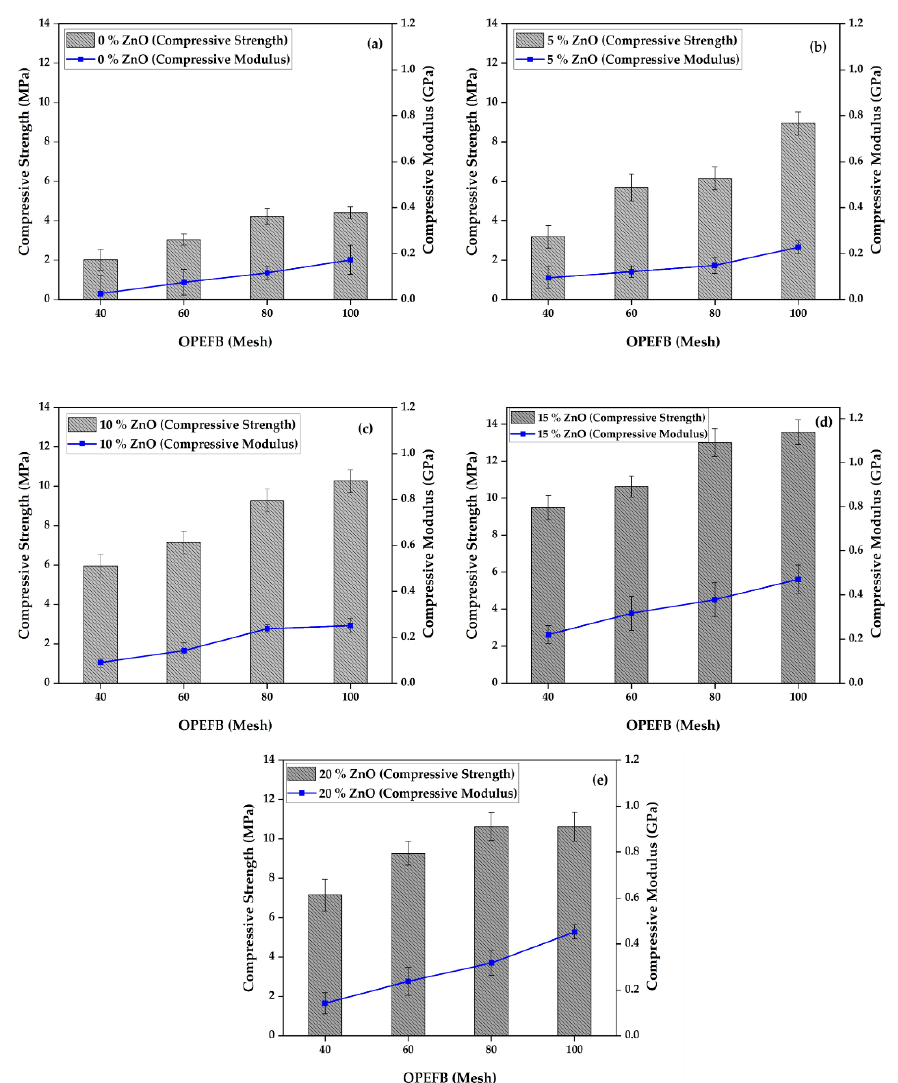
Figure 3. Compressive properties of foamed polymer composite at different OPEFB particle sizes and ZnO fillers, ( a ) 0% ZnO, ( b ) 5% ZnO, ( c ) 10% ZnO, ( d ) 15% ZnO, ( e ) 20% ZnO.